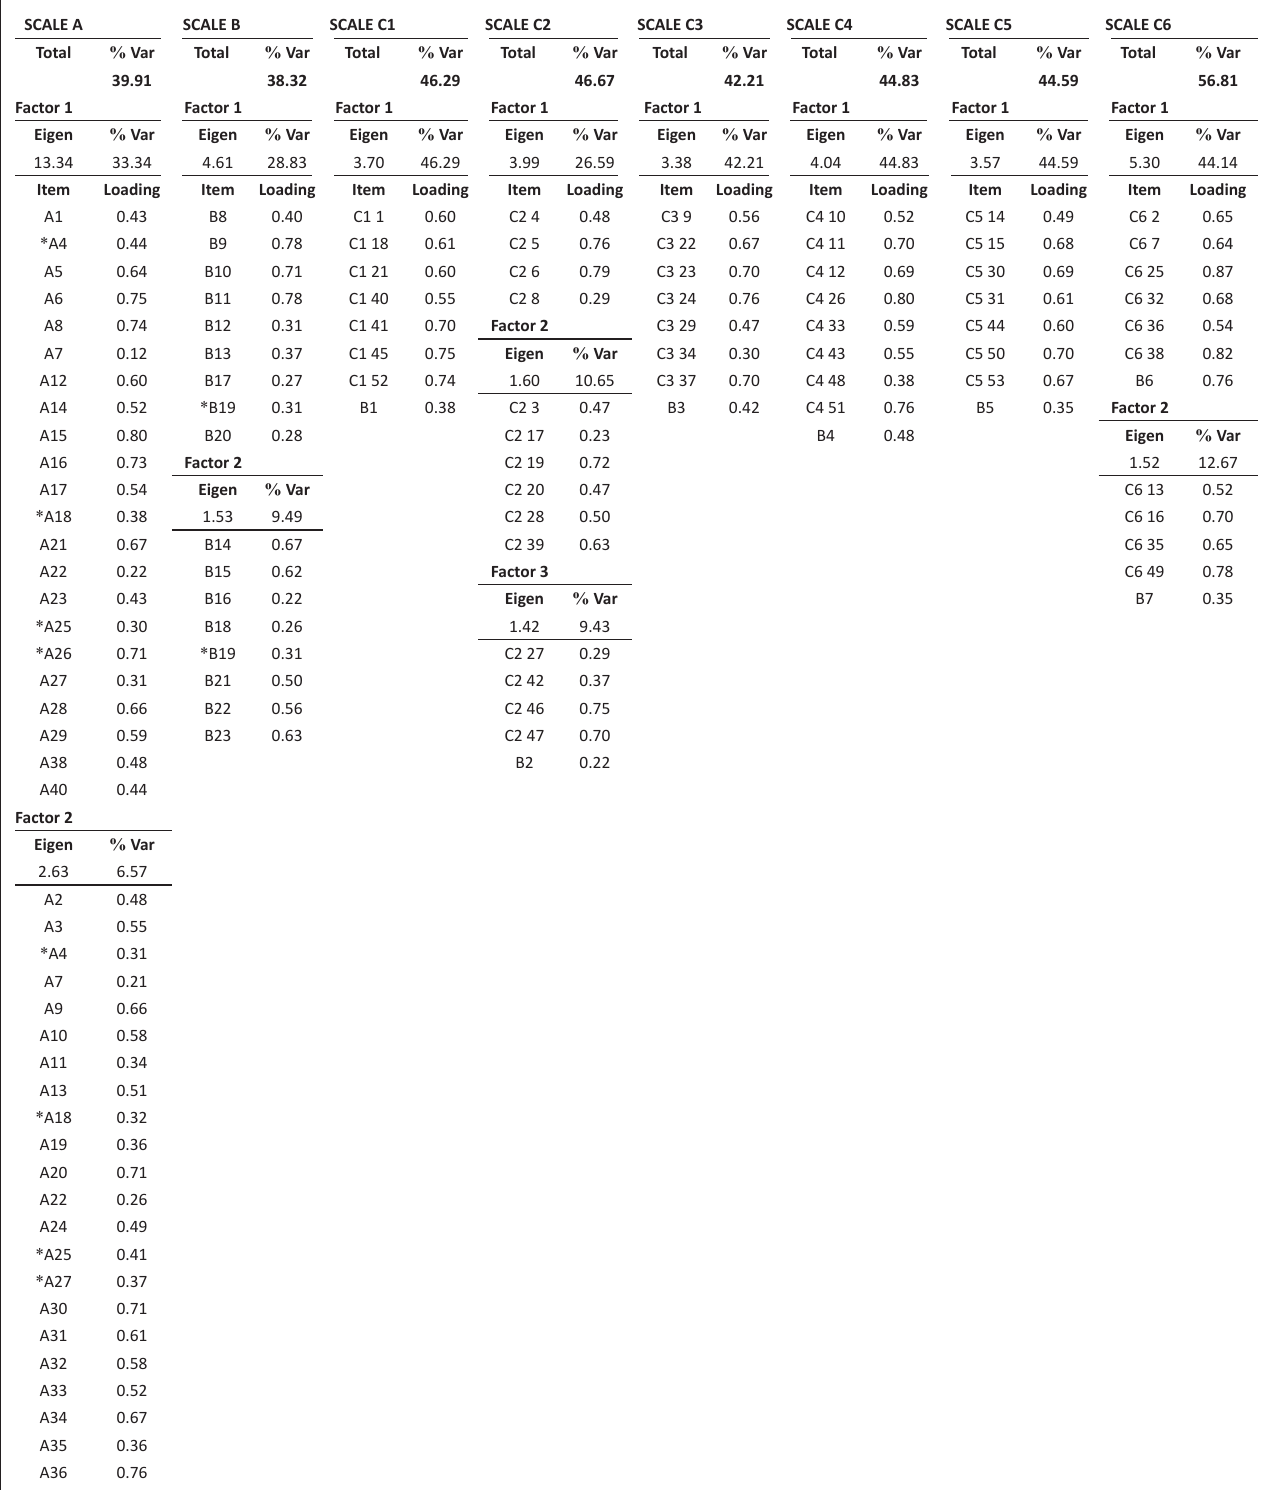
FIGURE 3: Findings from Exploratory Factor Analysis on the Subscales of the Experience of Work and Life Circumstances Questionnaire.